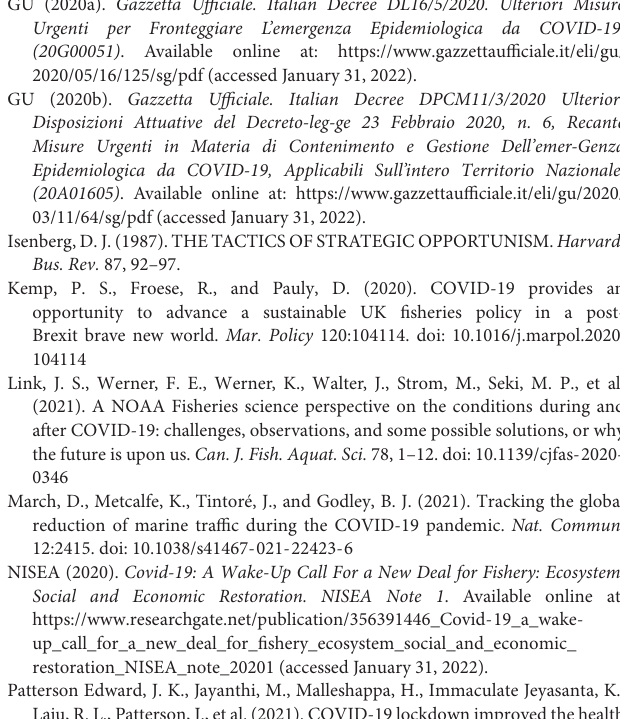
Supplementary Figure 1 | Violin plot of the values of LPUE per species, month and GSA. The values of the years 2015–2019 are represented by the violin, while those of the year 2020 (affected by the pandemic) are represented as red asterisks. Supplementary Figure 2 | (A) Absolute changes in the value of total Fishing Days by GSA, Season and Depth stratum; (B) absolute changes in the value of total Fishing Hours by GSA, Season and Depth